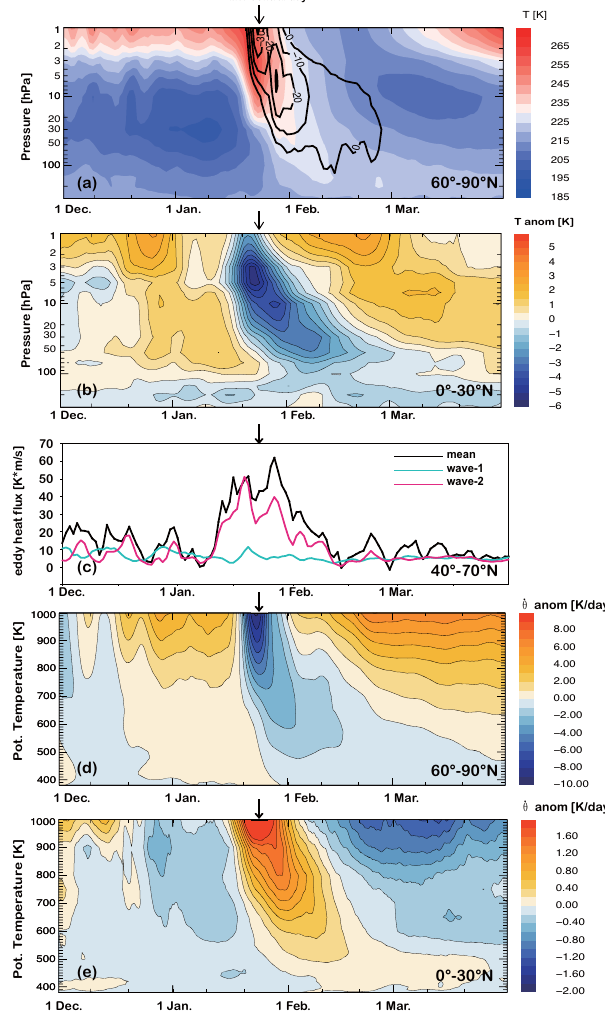
Figure 2. (a) Polar cap area weighted mean temperature (60–90 ◦ N) overlaid with zonal mean easterlies at 60 ◦ N (black contours in ms − 1 ), (b) tropical zonal mean temperature anomaly from the 24- year climatology (0–20 ◦ N), (c) eddy heat flux (40–70 ◦ N, black) on 100hPa and its decomposition into wave-1 (blue) and wave-2 (red) components (d) polar mean (60–90 ◦ N) anomaly of the heat- ing rates from the 24-year climatology Q = d θ/ d t = ˙ θ (for more details see the text), (e) same as (d) but for 0–30 ◦ N. The figures are based on the ERA-Interim